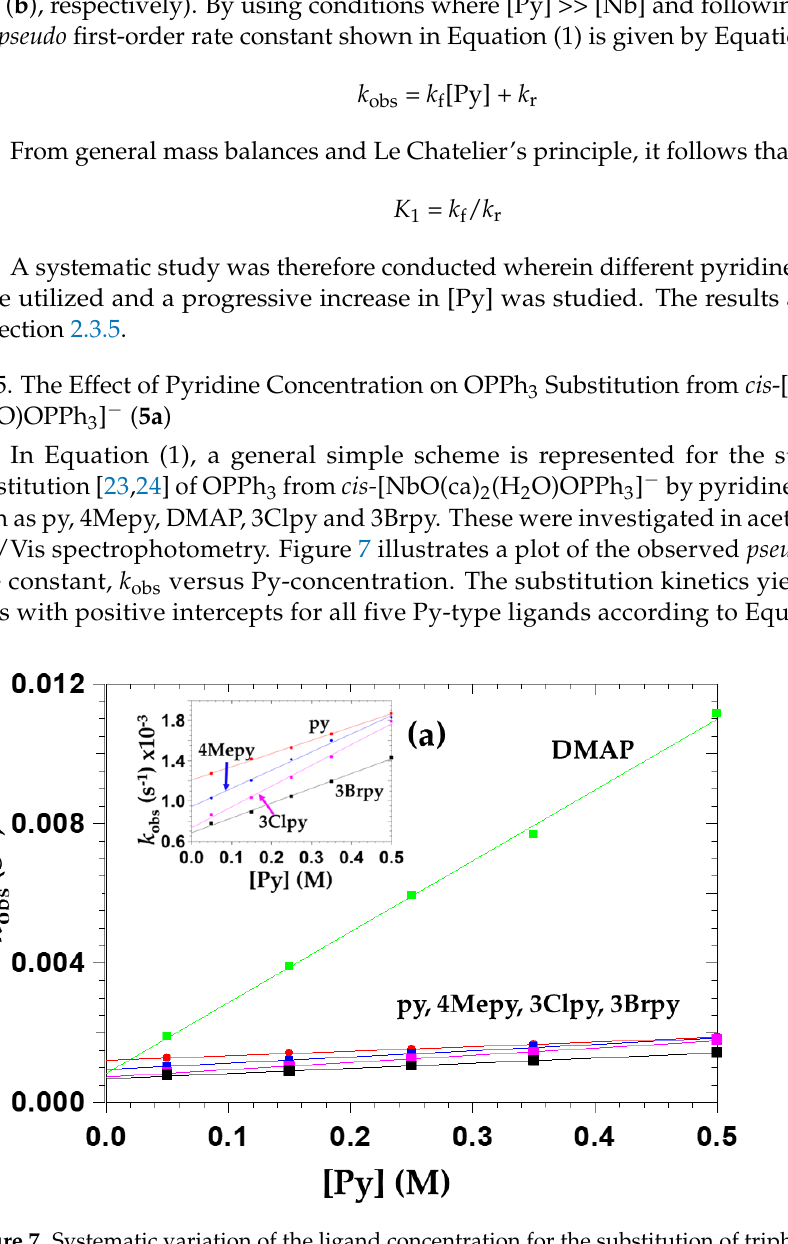
Figure 7. Systematic variation of the ligand concentration for the substitution of triphenylphosphine oxide from cis -[NbO(ca) 2 (H 2 O)OPPh 3 ] − by the pyridine-type ligands in acetonitrile at 31.2 °C. Insert ( a ) gives an enlarged perspective of the bottom four ligands. Ligand: green DMAP, red py, blue 4Mepy, purple 3Clpy, and black 3Brpy. Py = pyridine-type ligands.